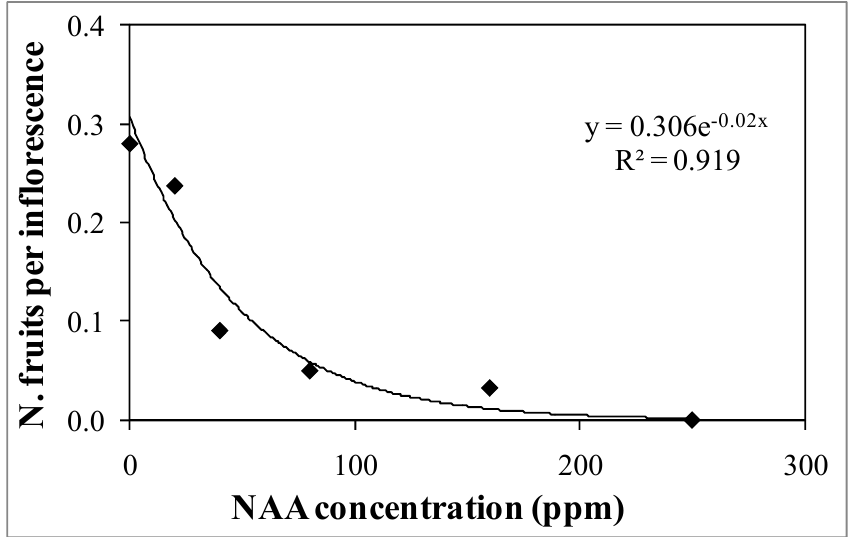
Figure 2. Relationship between used NAA concentrations and the number of fruits per inflorescence at the end of the vegetative season (2019) in a young intensive olive orchard of the cultivar Moraiolo. Values are means of 16 replicates per treatment.